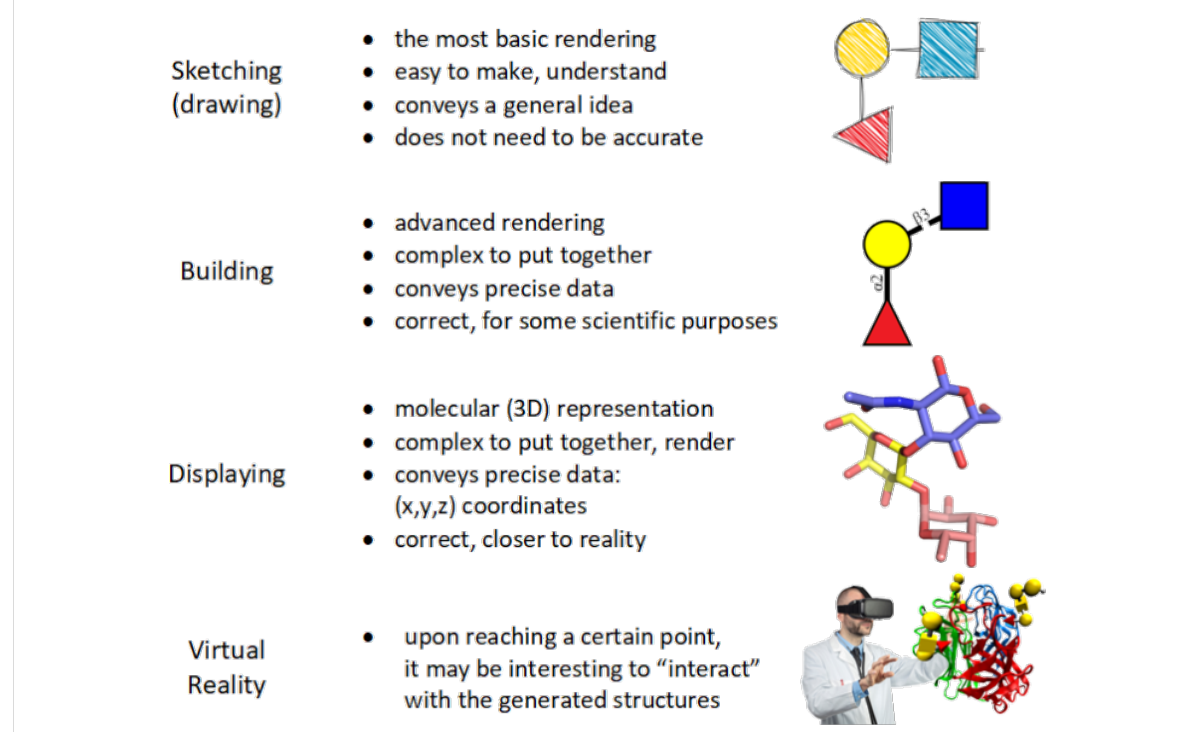
Figure 1: Levels of representation of glycans: from sketching to virtual